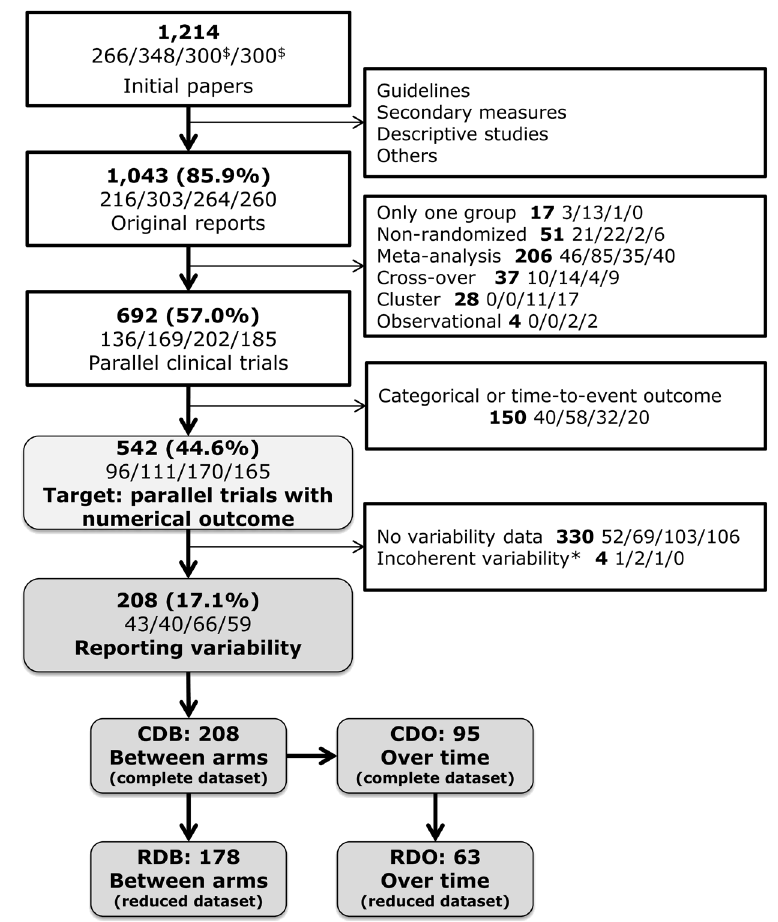
Figure 2. Flow-chart of the articles in the study. Percentages represent the number of papers with respect to the ones retrieved from the bibliographic search. The number of articles for each year (2004/2007/2010/2013) is specified in the second line of each box (separated by slashes). $ 300 papers were randomly selected for years 2010 and 2013. *Four papers were excluded because the variance of the change over time was inconsistent with both the baseline and final variances, which would lead to impossible absolute correlation estimates greater than 1. CDB and RDB are the datasets used in the main and heuristic analysis, respectively, for the between-arm comparison. CDO and RDO are the datasets used in the main and heuristic analysis, respectively, for the over-time